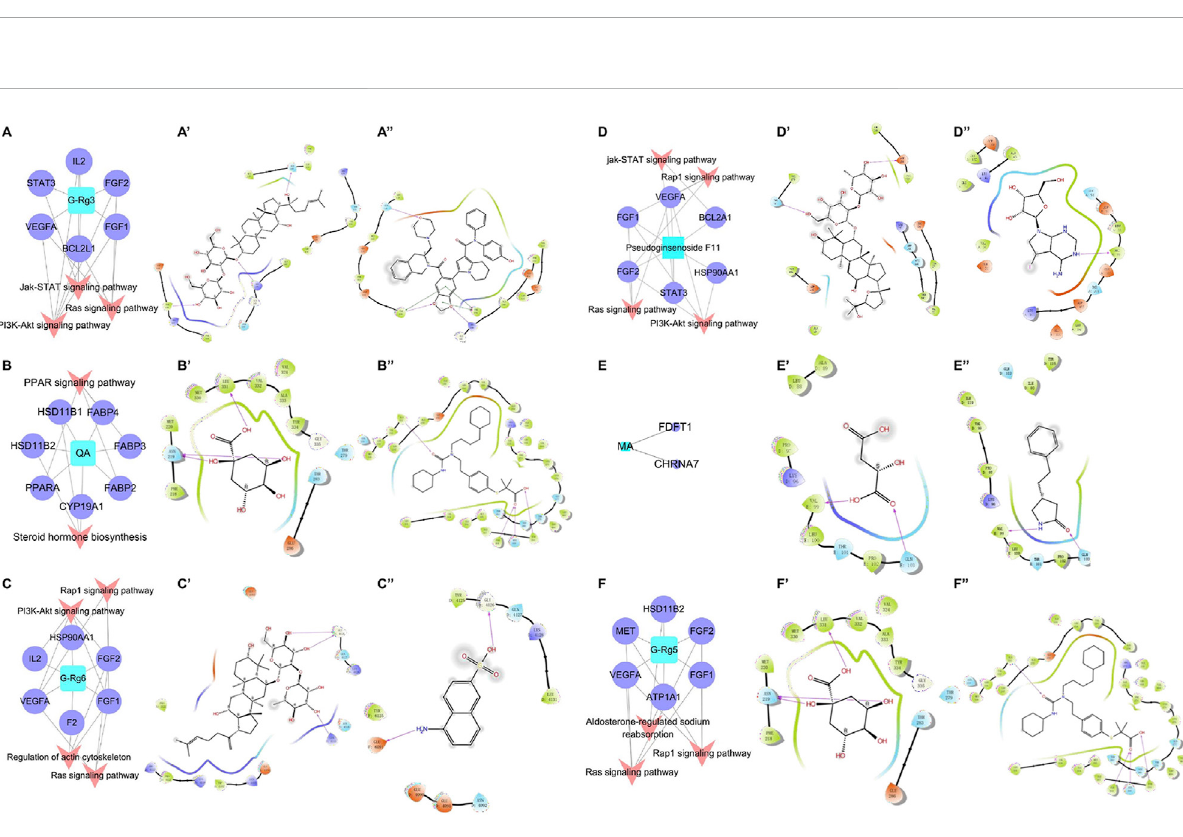
FIGURE 5 C-T-P network of the anti-heart failure and molecular docking 2D diagram. (A – F) C-T-P network of ginsenoside Rg3, quinic acid, ginsenoside Rg6, pseudoginsenoside F11, malic acid, and ginsenoside Rg5; (A ’– F ’ ) molecular docking 2D diagram of the bioactive molecules; (A ”– F ” ) molecular docking 2D diagram of positive